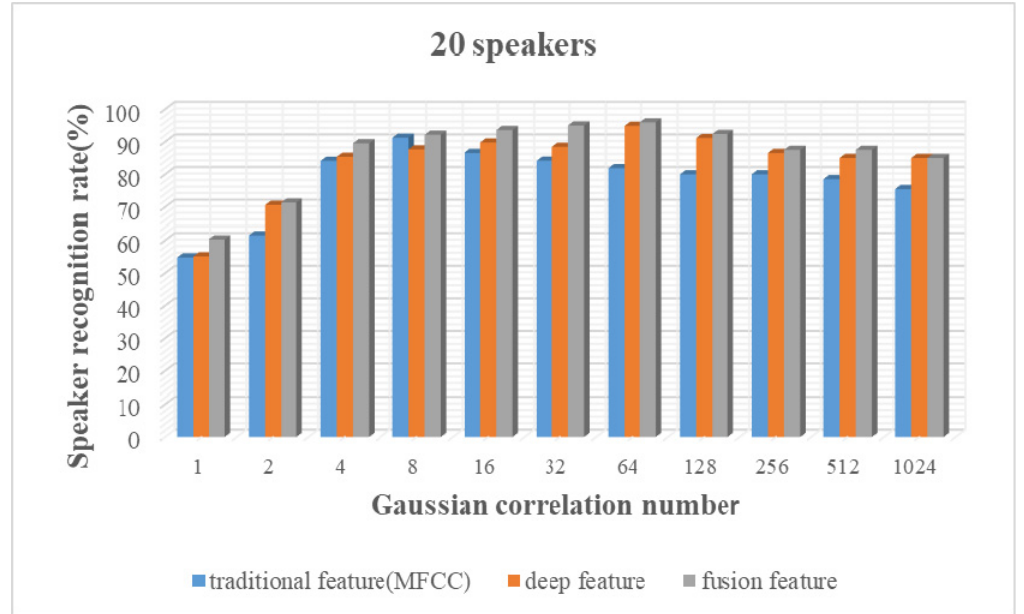
Figure 10. Speaker recognition rate based on three types of features (20 speakers).